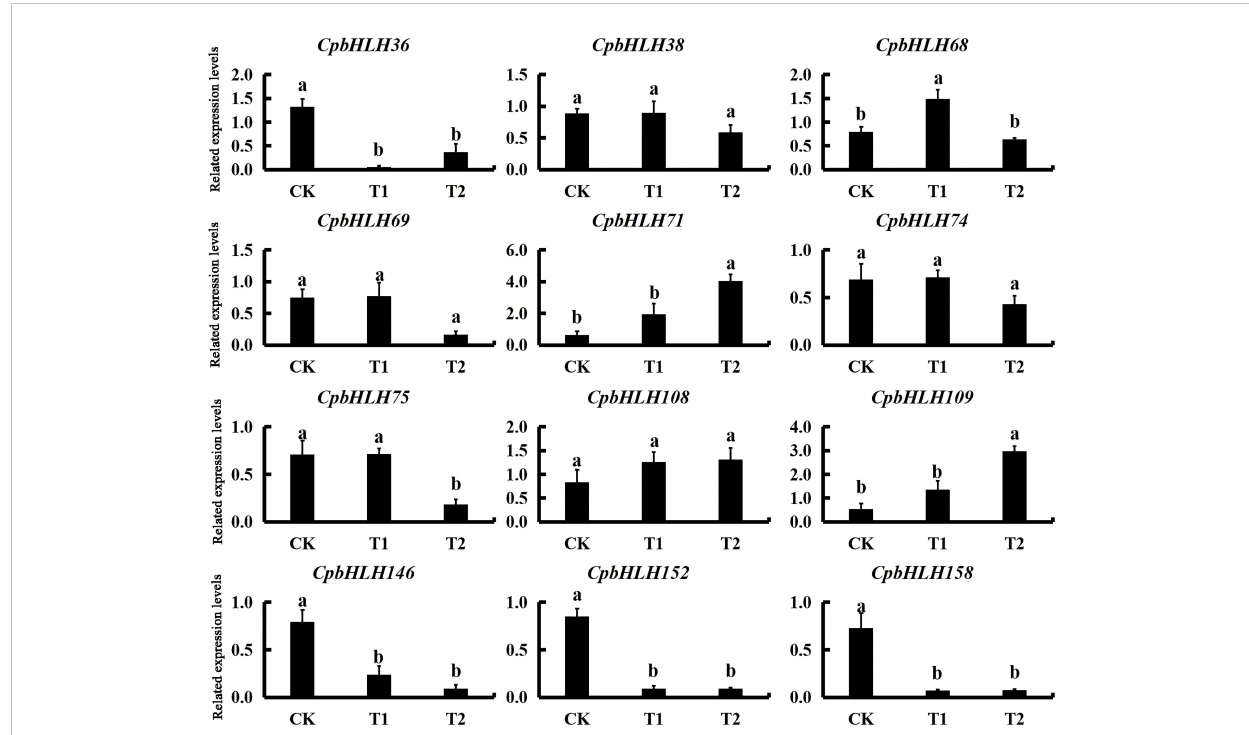
FIGURE 9 Expression pro fi les of the 12 candidate CpbHLH genes responding to salt stress treatments in pot experiment. The standard errors from three biological and three technical replications are presented as error bars. Following analysis of variance, signi fi cant differences identi fi ed by Duncan ’ s test ( p < 0.05), using SPSS v.22, are represented by different